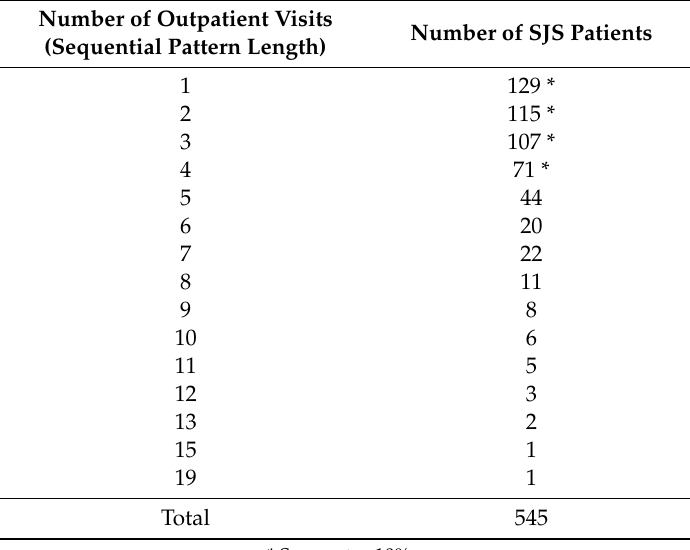
Table 6. Number of SJS patients with di ff erent numbers of outpatient